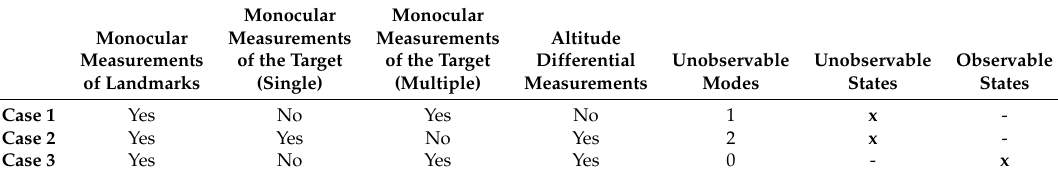
Table 1. Results of the nonlinear observability analysis of the proposed